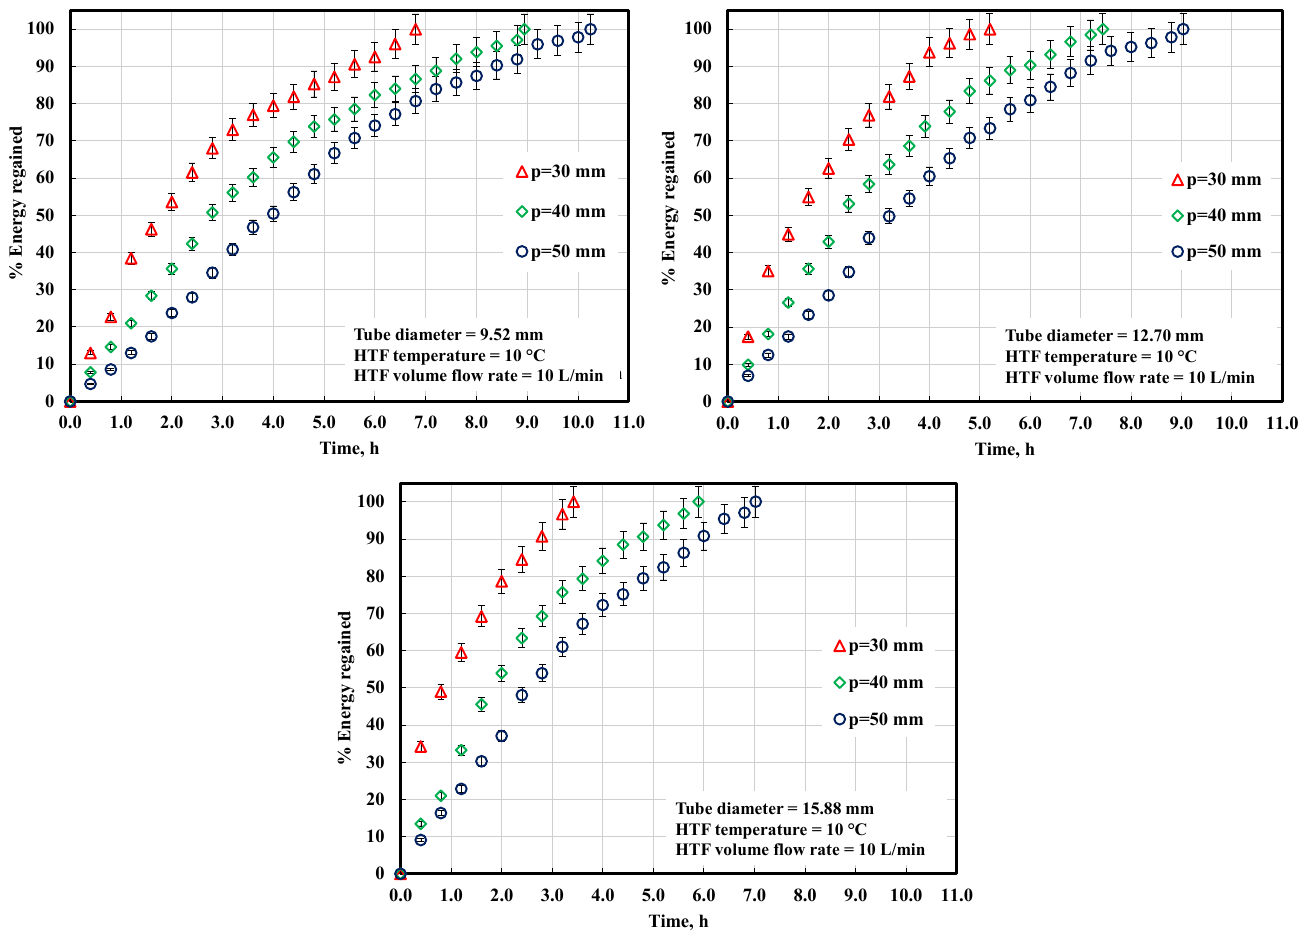
Figure 4. Percentage of energy regained with time for different coil pitches with coil tube diameters during discharging process.